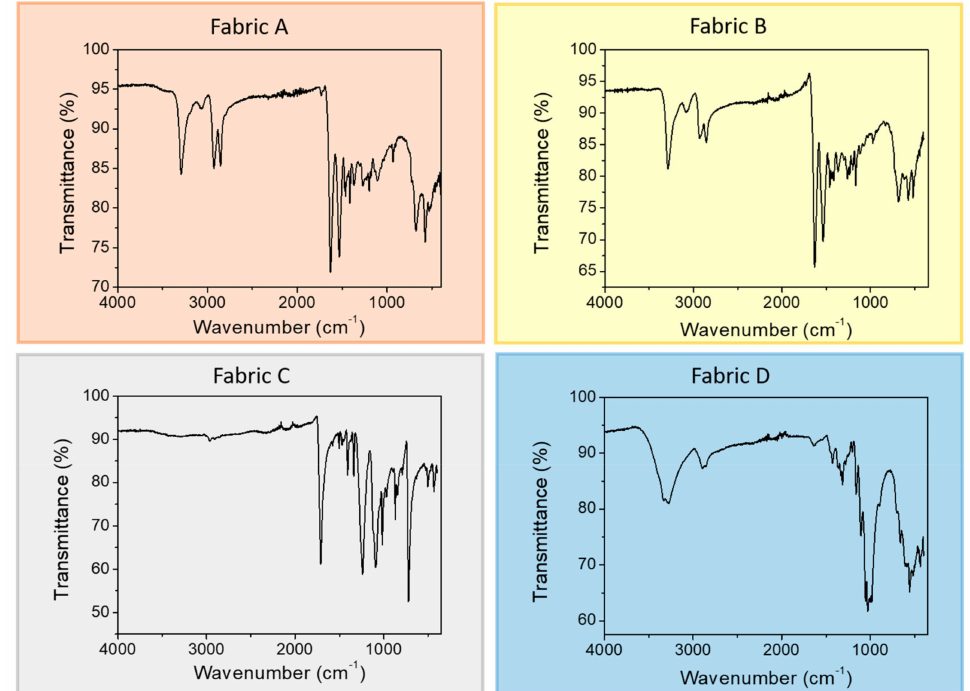
Figure 2. Fourier transform infrared (FT-IR) pattern for the four fabric